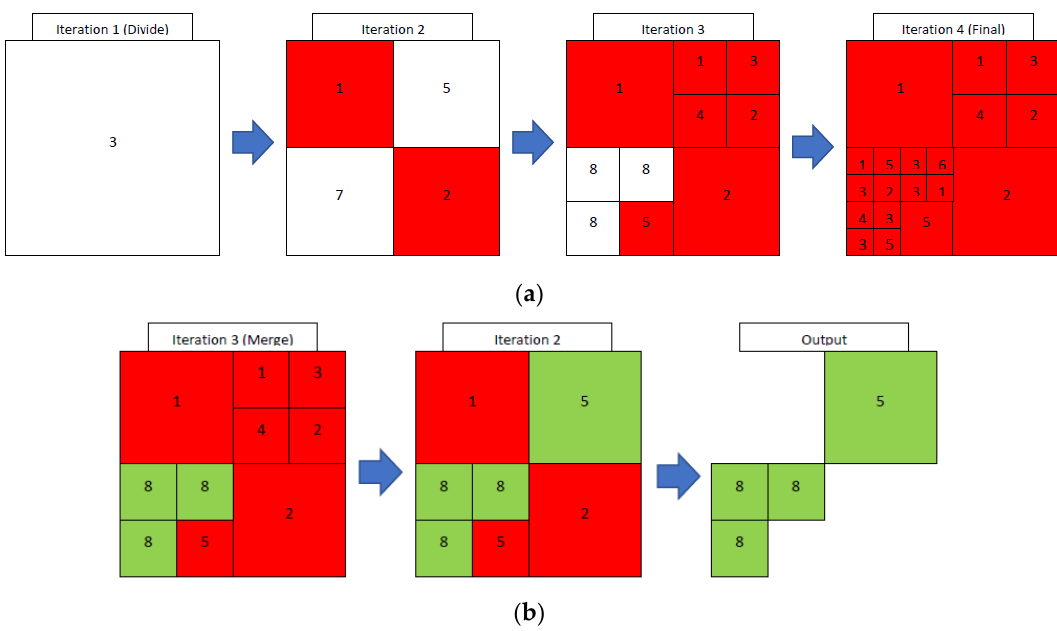
Figure 2. ( a ) Quadtree branch creation NOTE: metric values are shown as whole numbers for illustration purposes. The metric values normally fall between 0 and 1; ( b ) quadtree return values.